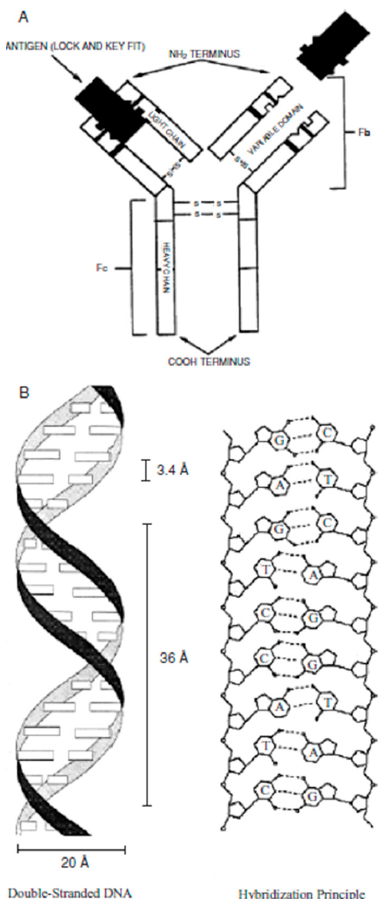
Figure 3. Schematic of two different bioreceptors: ( A ) antigen and ( B ) nuclei acid [68].